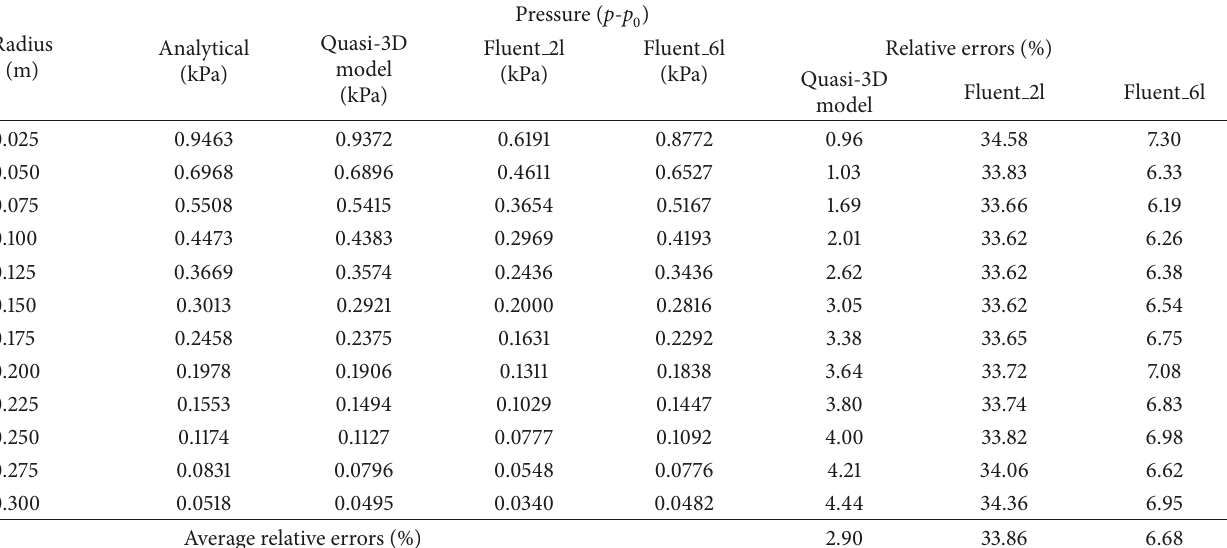
Table 2: Grout pressure distribution over radius at t = 20 s in Case 1.